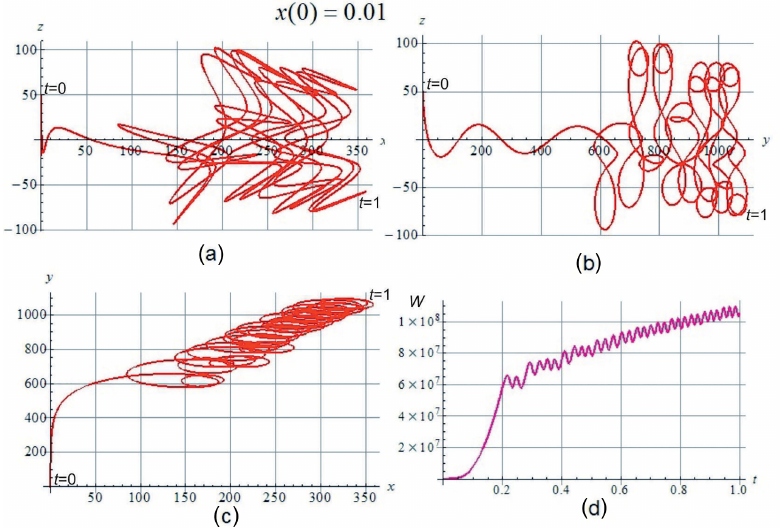
Figure 2. The orbit pattern at x( 0 ) = 0 . 01: (a) projected to the (x,z) plane, (b) projected to the (y,z) plane, (c) projected to the (x,y) plane. (d) Time dependence of the kinetic energy.